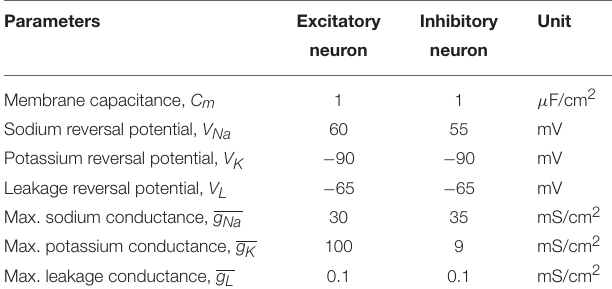
Table 1 ) were taken from the literature (for RS neuron: Traub et al., 1991 and Mainen et al., 1995; for FS neuron: Wang and